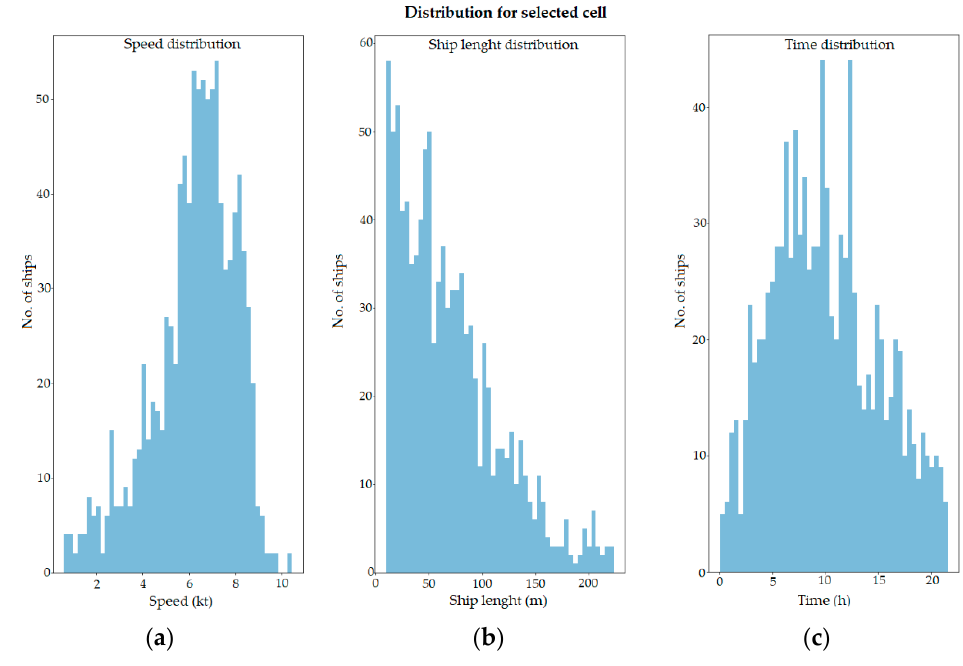
Figure 9. Distributions for ship type: ( a ) speed; ( b ) length; ( c ) time.